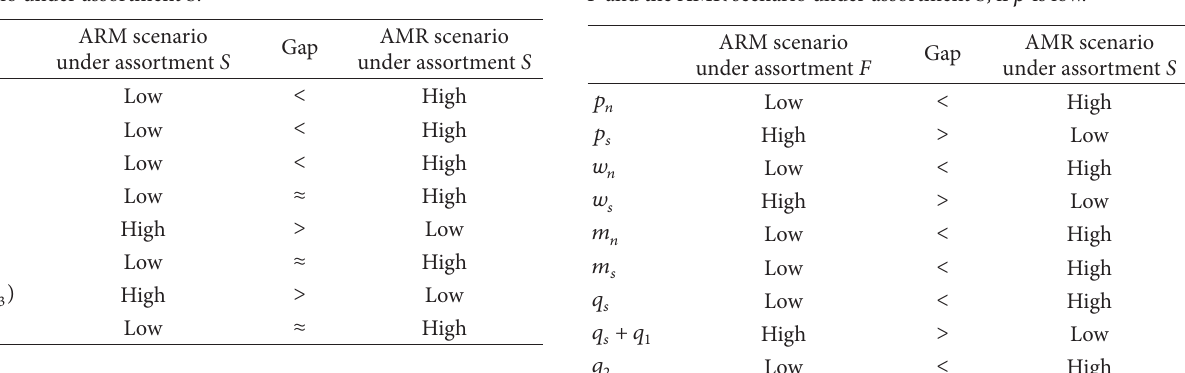
Table 2: Comparison between the ARM scenario and the AMR scenario under assortment S .